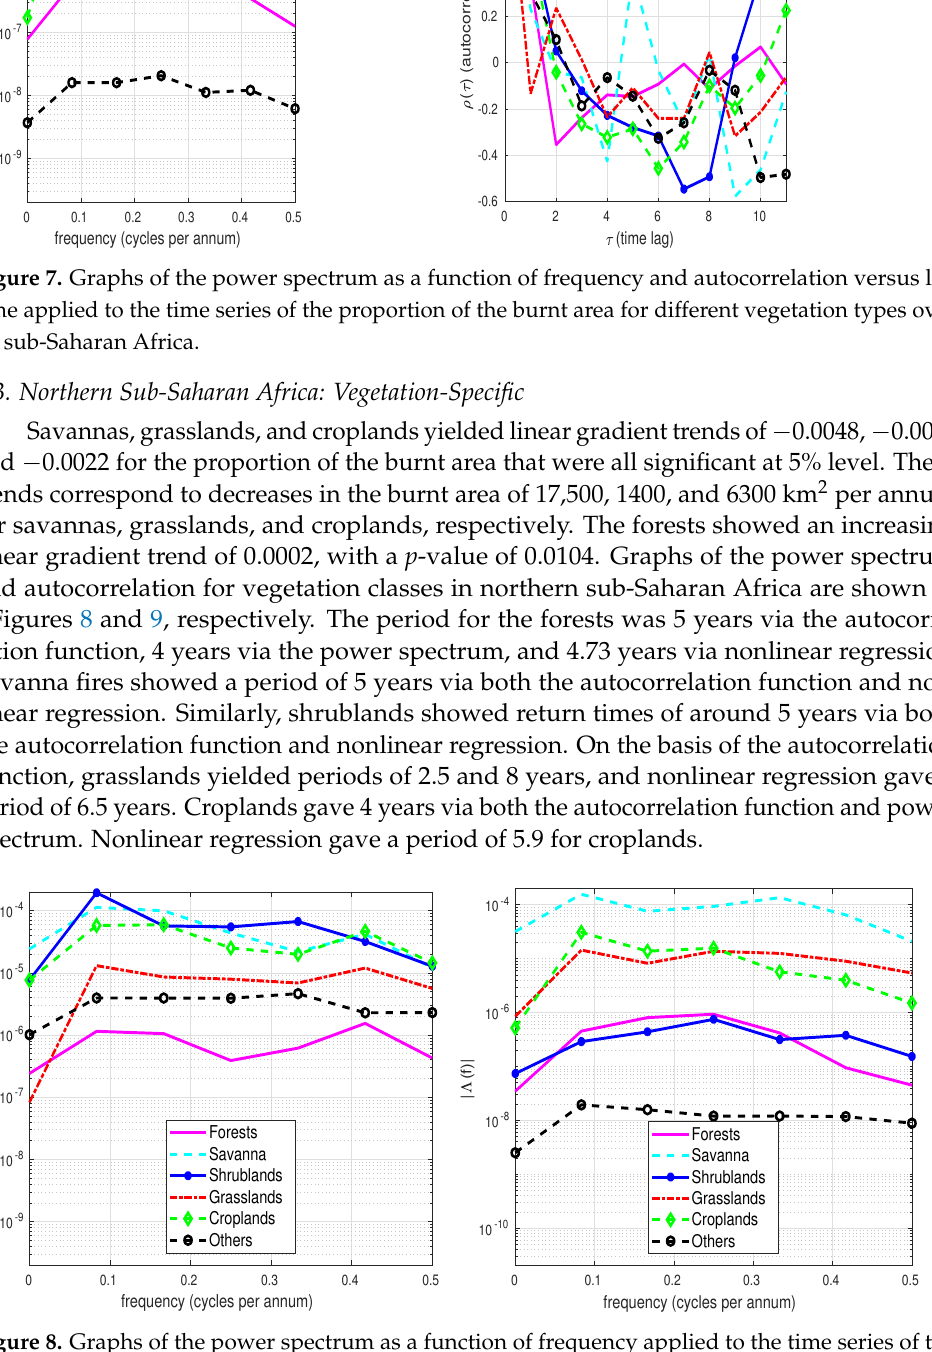
Figure 8. Graphs of the power spectrum as a function of frequency applied to the time series of the proportion of the burnt area for different vegetation types in ( left ) southern-hemisphere Africa and ( right ) northern sub-Saharan